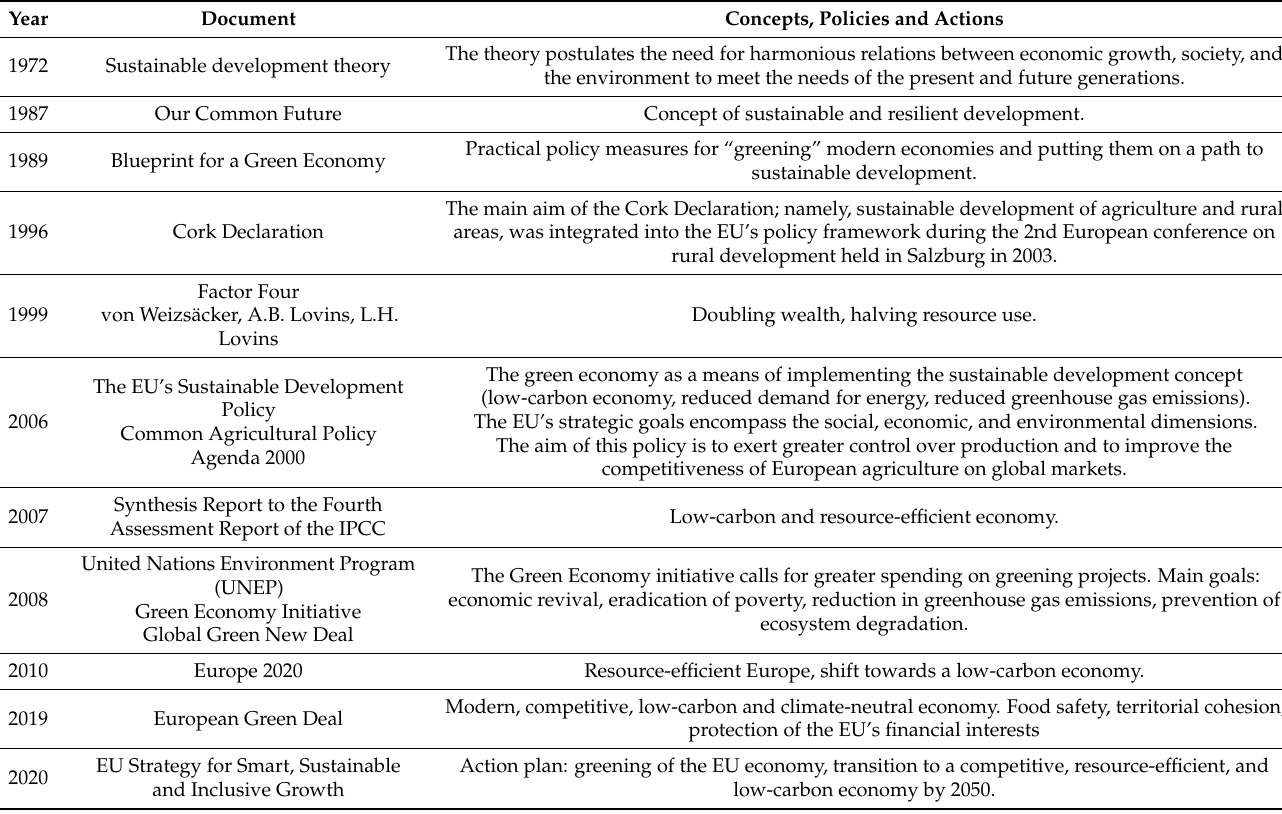
Table 1. Evolution of the green economy